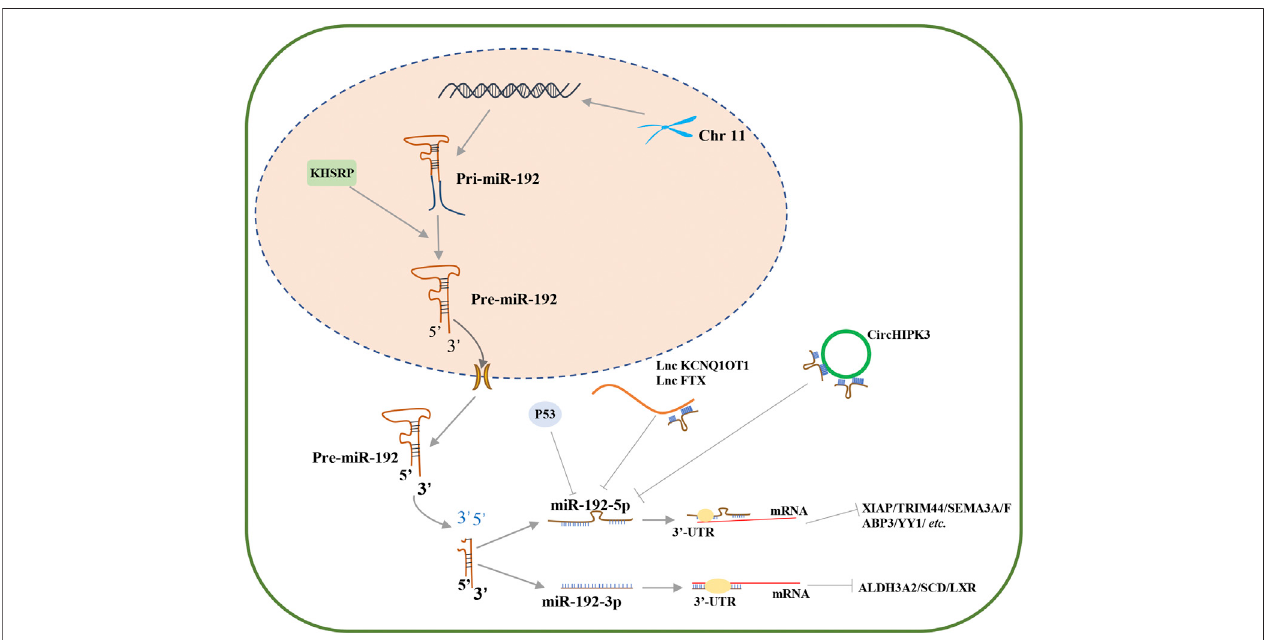
FIGURE 1 | The biogenesis and regulation of miR-192-5p. Pre-miR-192 could produce two mature miRNA transcripts, miR-192-5p and miR-192-3p, each of whichcanregulategeneexpressionbytargeting3 ′ -UTRofmRNA,suchasXIAP,TRIM44,SEMA3A,FABP3,andYY1formiR-192-5p,andALDH3A2,SCDandLXRfor miR-192-3p.Incellnucleus,KHSRPcanpromotematurationofpri-miR-192,therebyfacilitatingtheproductionofmiR-192-5p.Incytoplasm,P53andnoncodingRNAs, such as circHIPK3, lnc KCNQ1OT1 and lnc FTX, can inhibit the expression of miR-192-5p.